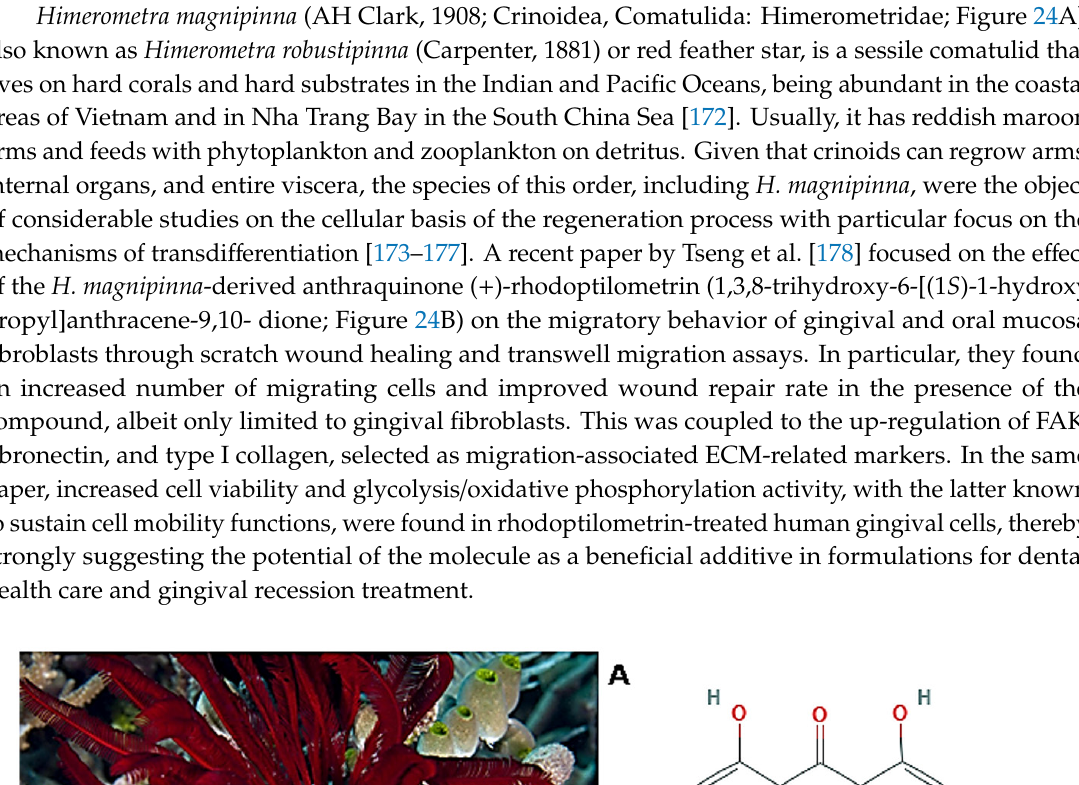
Figure 23. An individual of Astropecten indicus . © Ria Tan (CC BY-NC-ND 2.0); https: // www.flickr.com / . Figure 23 . An individual of Astropecten indicus . © Ria Tan (CC BY-NC-ND 2.0); https://www.flickr. com/.